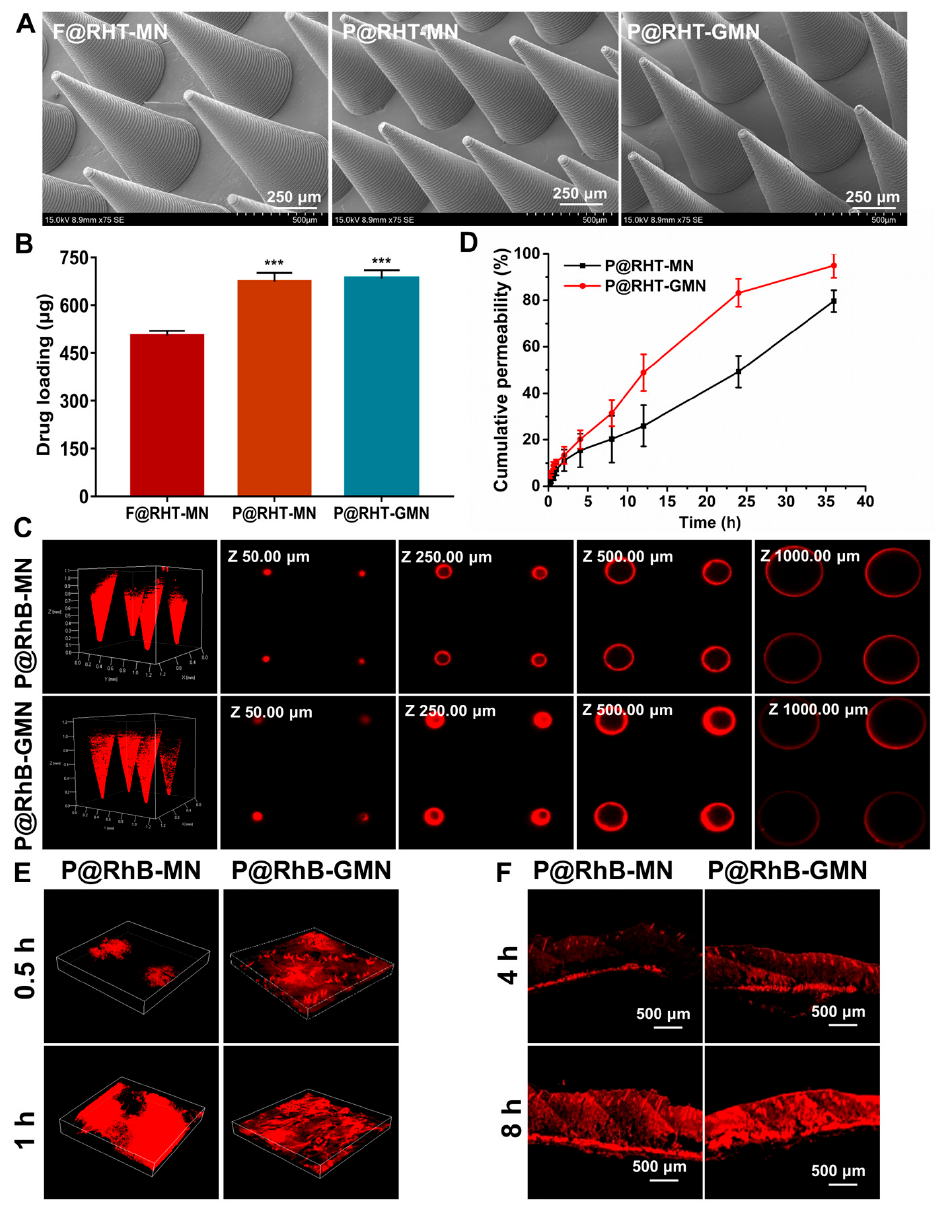
Figure 9. Characterization of optimized MNs: ( A ) morphology of MNs observed by SEM; ( B ) drug loading ( n = 3). *** p < 0.001 vs. F@RHT-MN; ( C ) the 3D reconstruction of P@RHT-MN and P@RHT- GMN and at their counterparts at different depths captured by CLSM to observe drug distribution; ( D ) in vitro cumulative transdermal permeability of RHT ( n = 3); the permeation of RhB into the ( E ) excised and ( F ) living skin tissues to evaluate the transdermal delivery efficiency of passive and gas-propelled